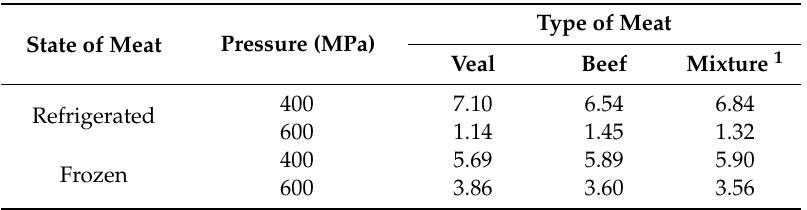
Table 1. D-values (min) for Shiga toxin–producing Escherichia coli in refrigerated and frozen meatballs pressure treated at 400 or 600 MPa (N = 3 trials, n = 3 samples per